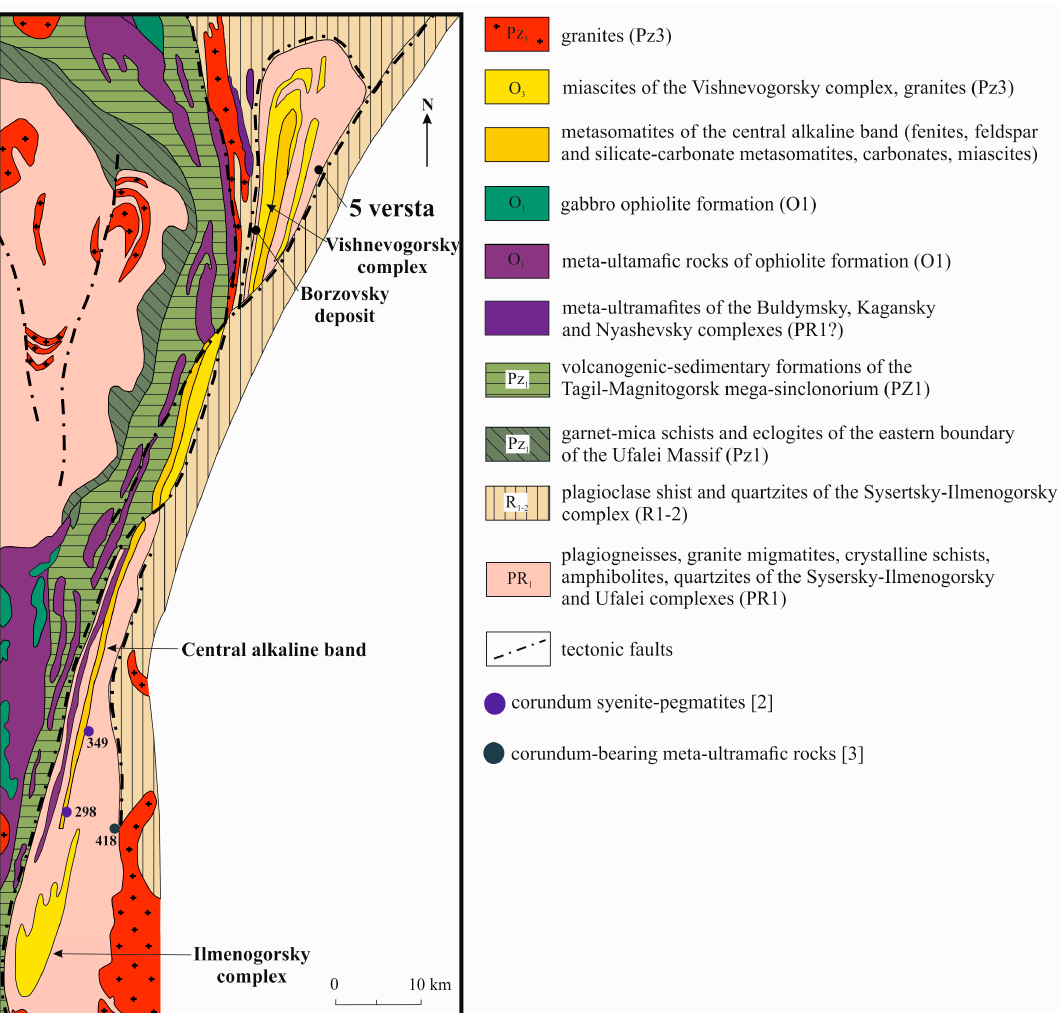
Figure 1. Geology of the Ilmenogorsky-Vishnevogorsky alkaline-carbonatite complex [18]. Coordinates of the 5th versta deposit are 55°54’03”N, 60°41’16“E.